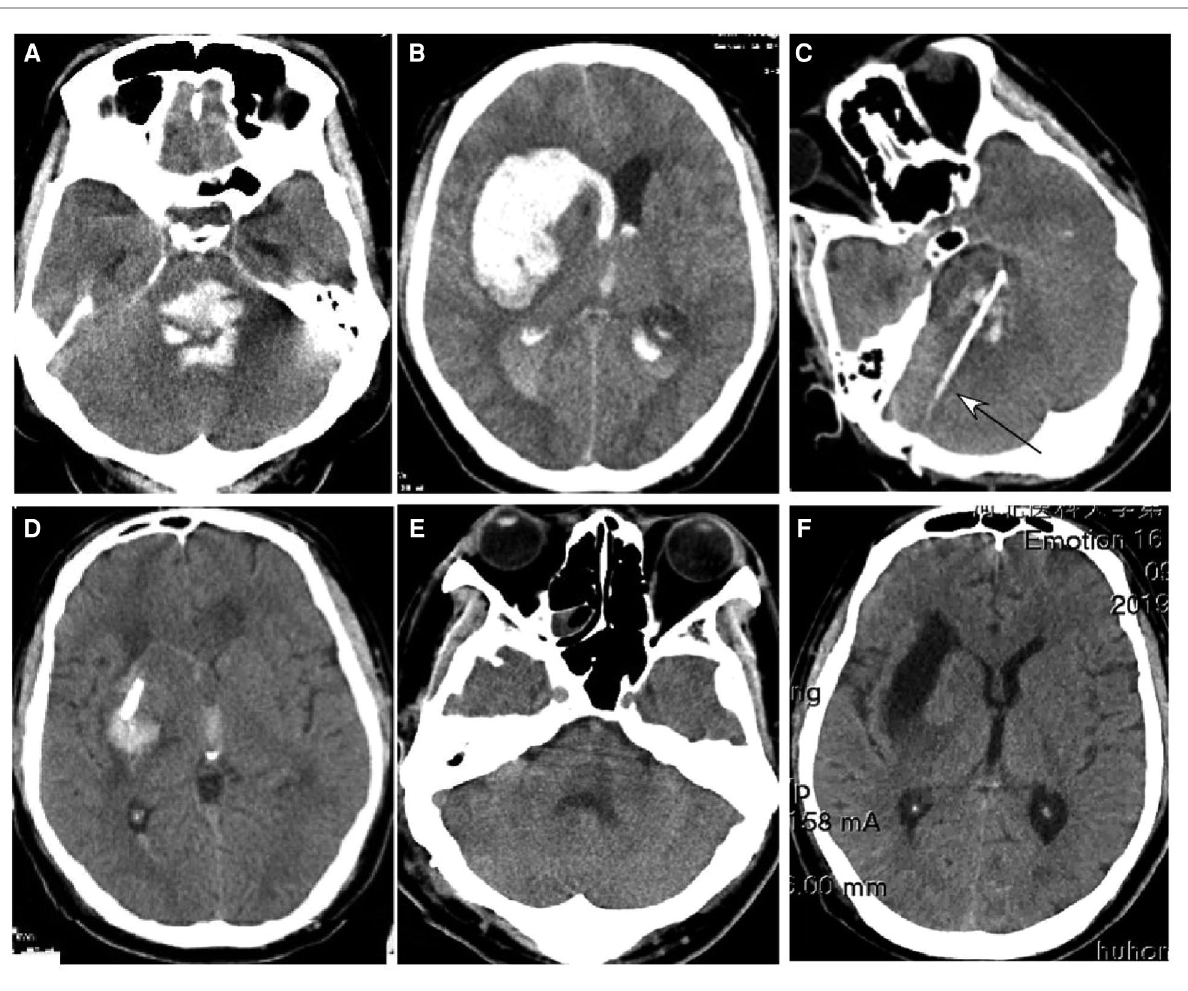
FIGURE 5 A 39-year-old man had a sudden onset of unconsciousness 3 h before presentation. ( A , B ) A head CT scan showed severe hemorrhage in the brainstem ( A ), basal ganglia, and lateral ventricle ( B ). The patient was in a coma with no spontaneous breathing and with a Glasgow Coma Scale (GCS) score of 3 (E1VTM2). ( C , D ) An ultra-early stereotactic aspiration was performed (arrow). After surgery, the hemorrhage greatly reduced, and the patient regained his spontaneous breathing with a GCS score of 4 (E1VTM3). ( E , F ) One month later, the hemorrhage had completely